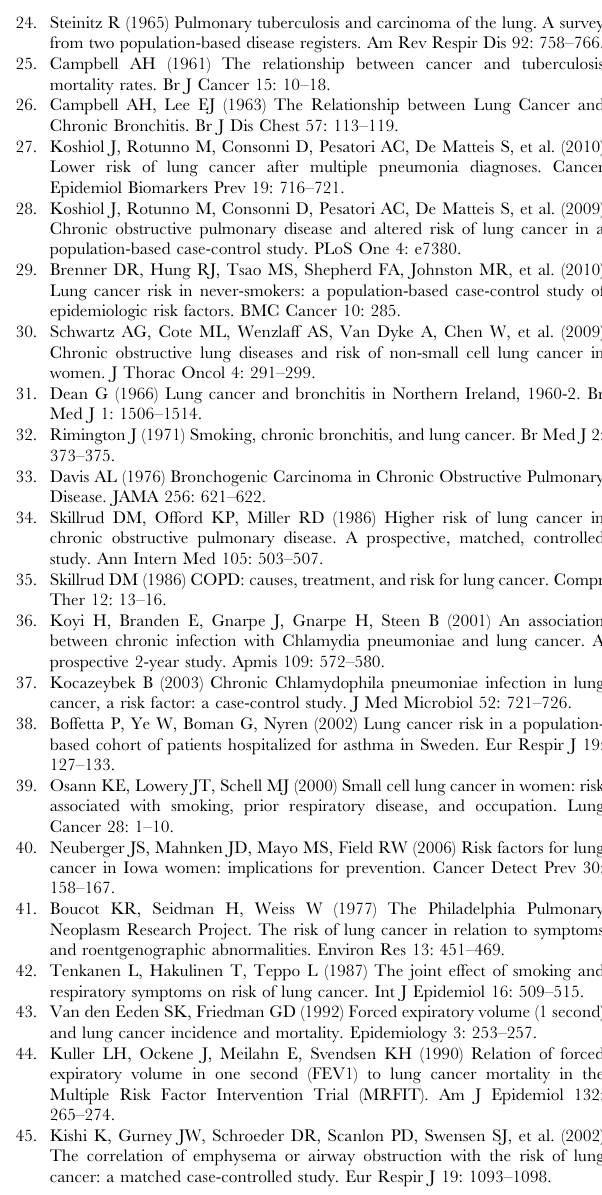
Figure S11 Funnel plot of the effects of pneumonia across studies.